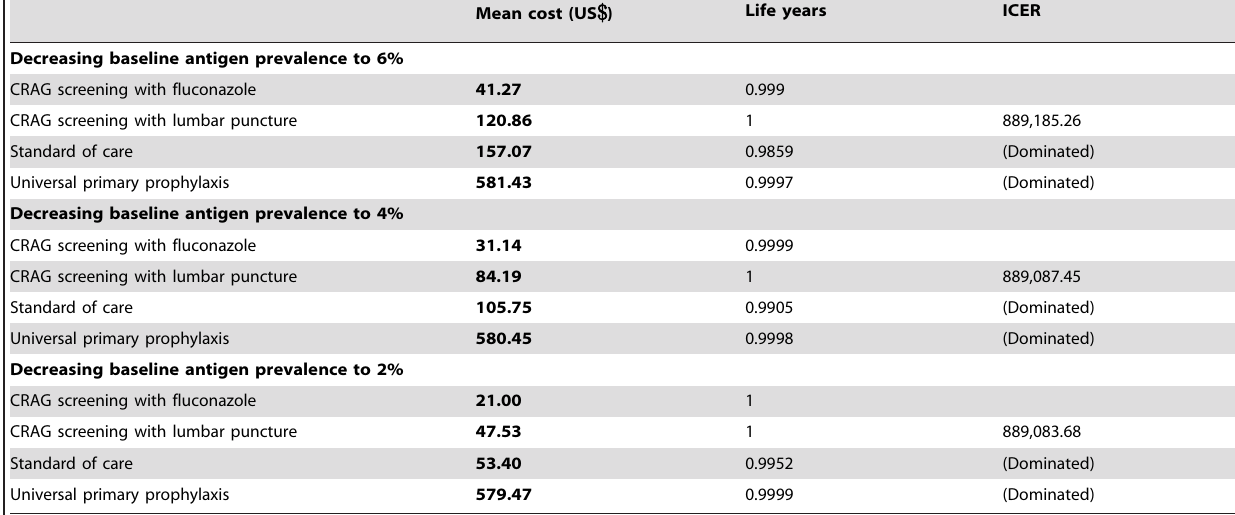
Table3(B). Sensitivity analysis: impact of varying the prevalence of cryptococcal antigenaemia in the